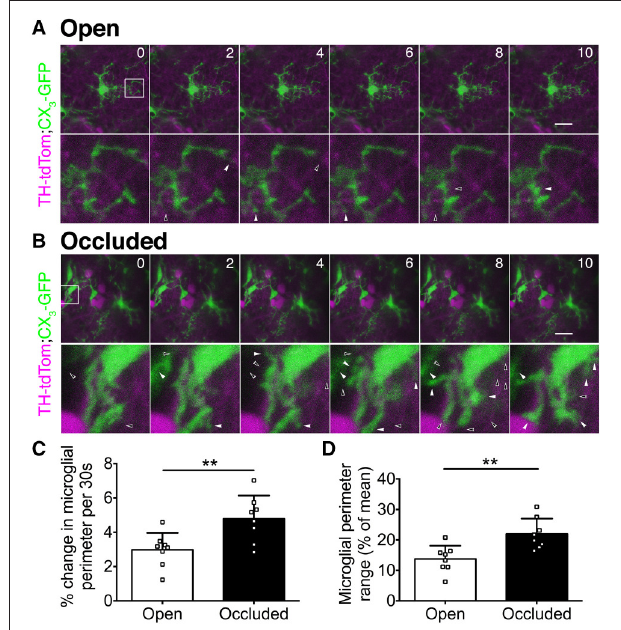
FIGURE 5 | In vivo 2-photon imaging reveals activity-dependent changes in microglial dynamics. (A,B) Upper: time-lapse image series showing microglial dynamics at select time points. Numbers: time (minutes). Images were captured at 30s intervals. Scale bars: 20 µ m. Lower: zoomed images of boxed regions. Left-to-right: solid-open arrowhead pairs indicate process retraction; open-solid arrowhead pairs indicate process extension. (C) Greater perimeter change in occluded OBs ( ** p = 0.008, t = 3.06, t -test). (D) Greater perimeter range over time in occluded OBs ( ** p = 0.004, t = 3.49, t -test). (C,D) : n = 8 microglia from 2 open OBs and 8 microglia from 2 occluded OBs from 2 naris-occluded